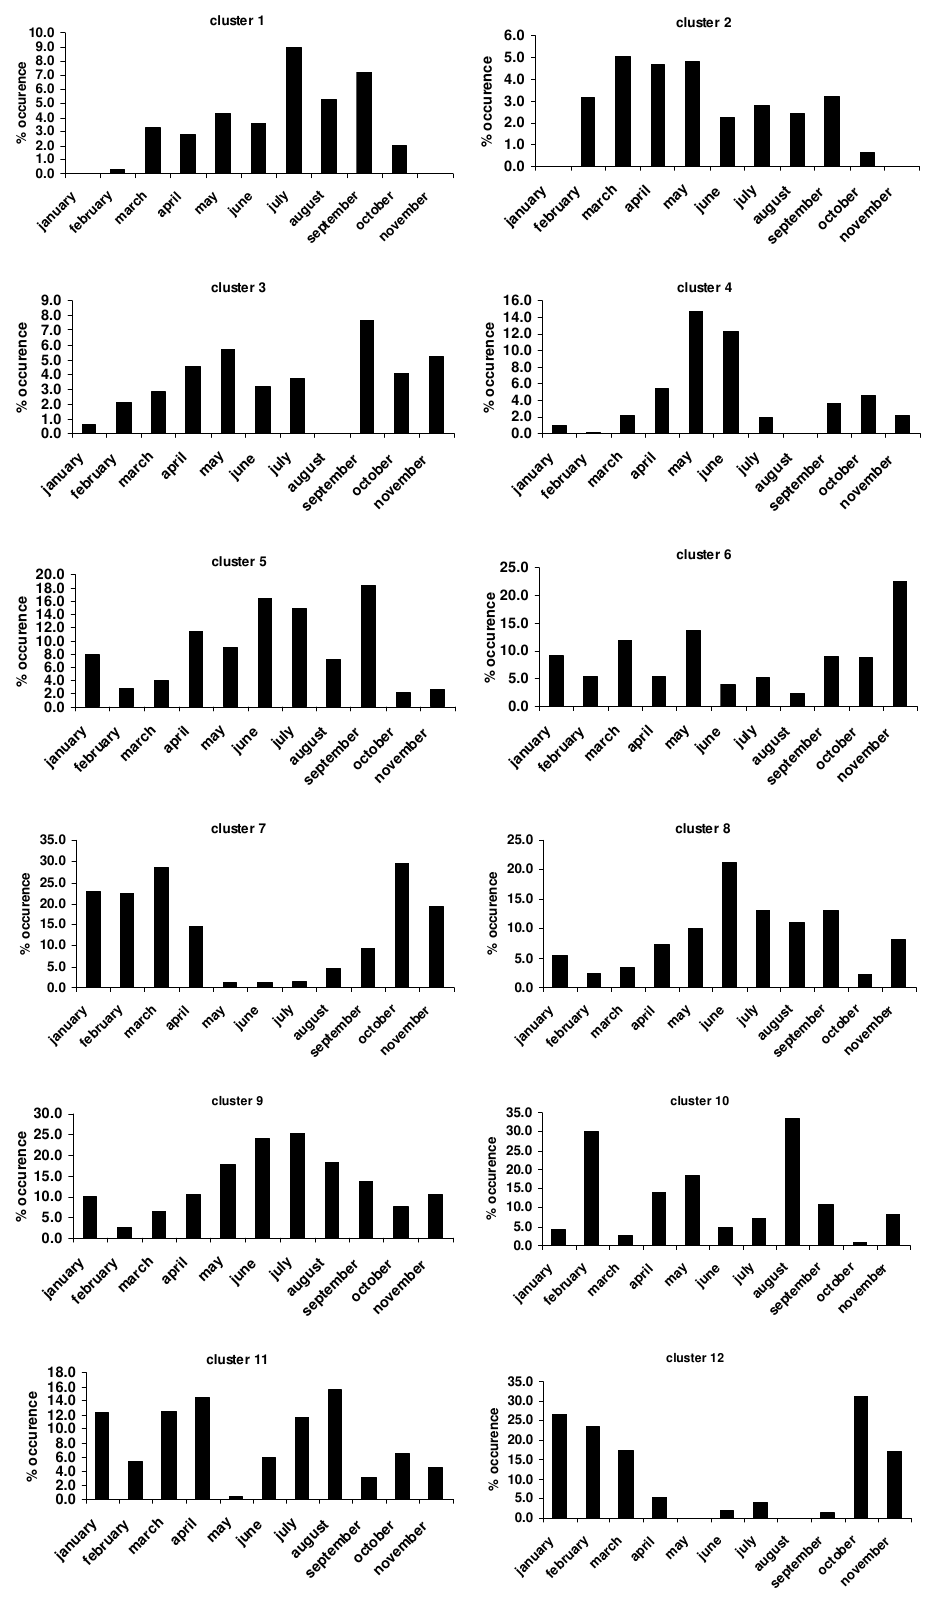
Fig. 6. Monthly occurrence (% among all 12 clusters) of SMPS clustering analysis.